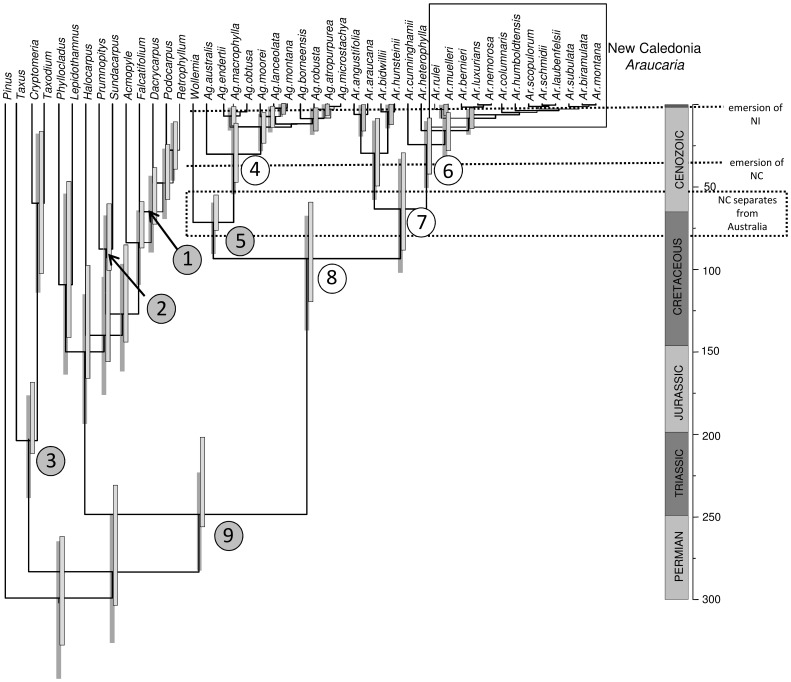
Divergence time estimates for Araucariaceae.The topology presented is the maximum credibility tree (median node heights) obtained by pooling four separate runs under two constraint scenarios (see Table 1, and text for details). Circles indicate nodes that were included in the assessment of candidate nodal constraints, and the dark shaded circles indicate nodes that were constrained for the BRC analyses (see Table 1 for details). Node bars (nodes with a posterior probability ≥0.75) indicate the 95% HPD of divergence times for the two prior scenarios: left, log normal prior mean  =  minimum fossil age +50%; right, log normal prior mean  =  minimum fossil age +10% (NC, New Caledonia; NI, Norfolk Island).